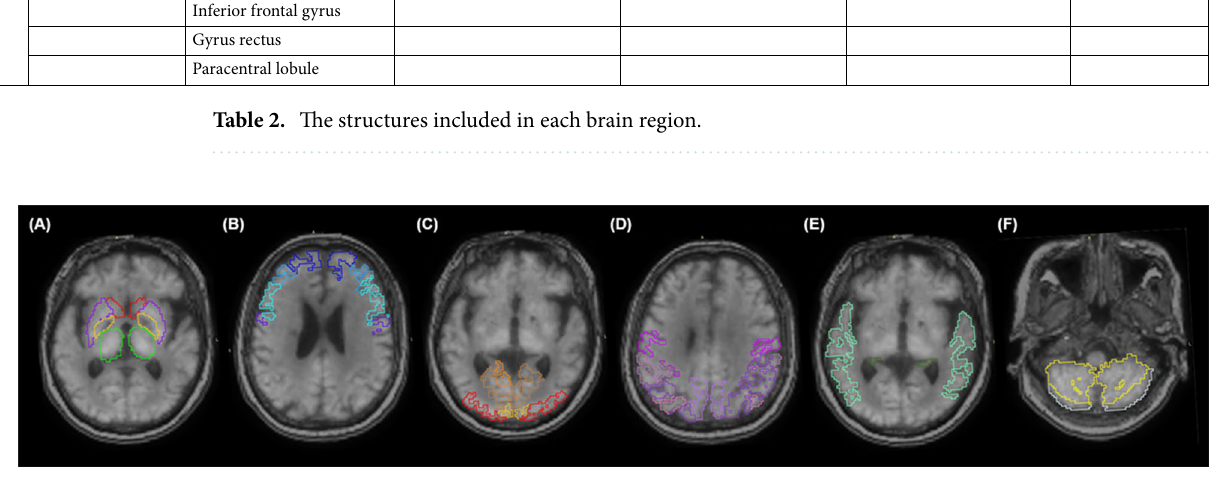
Figure 4. Representative images for outline contours of volumes of interest (VOIs). The VOIs for central structures ( A ), frontal ( B ), occipital ( C ), parietal ( D ), temporal ( E ) lobes, and cerebellum ( F ) with colored outline contours were automatically set in co-registered PET-MR images by the AAL-merged atlas provided by